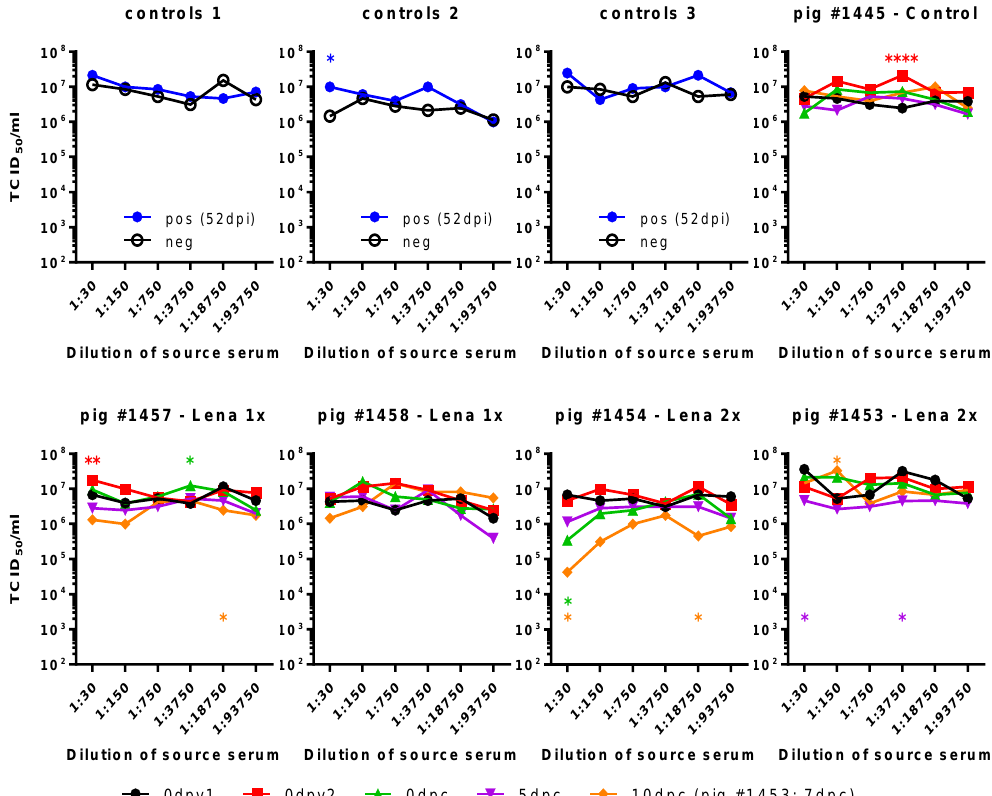
Figure 6. Impact of sera on virus titers in MDM cultures. Serially diluted immune sera were pre-incubated with Lena. Then, MDMs were infected with these immune complex mixtures, washed, and incubated for a total of 16 h. The supernatants were titrated in triplicates. Controls 1–3 show the viral titers when PRRSV-Ab-negative serum (neg) or PRRSV-immune serum (pos, from 52 dpi) were used as immune sera. Pig #1445, from the control group, had not been immunized before challenge. Pigs #1457 and #1458, from the “Lena 1x” group, were vaccinated once with BEI-inactivated Lena + adjuvant, and pig #1454, from the “Lena 2x” group, was vaccinated twice with the same vaccine. before challenge, 0dpv2 = four weeks before challenge. Statistical analysis was performed with ordinary 2-way ANOVA, followed by Tukey’s multiple comparison test. Within each dilution, the sera from different time points were compared with the “initial serum” (neg or 0dpv1). Symbols: * = p < 0.05, ** = p < 0.01, *** = p < 0.001, **** = p < 0.0001. Color of the asterisks denote to which serum they belong.